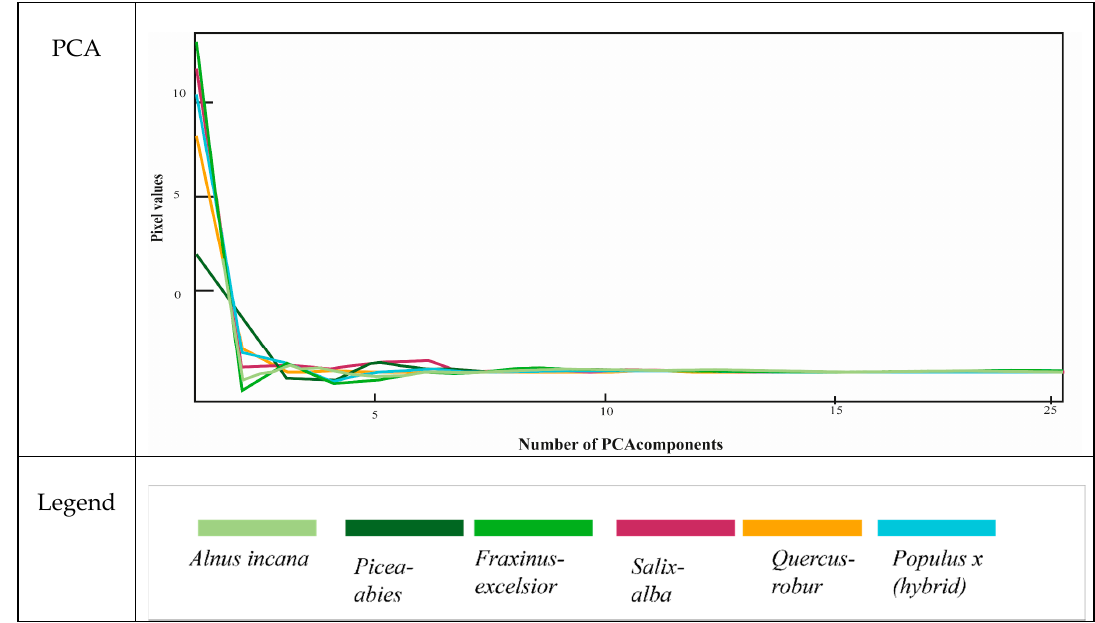
Figure 7. Spectra of training samples for each tree class using spectral dimensionality-reduced images resulting from PCA, MNF, and ICA transformations.